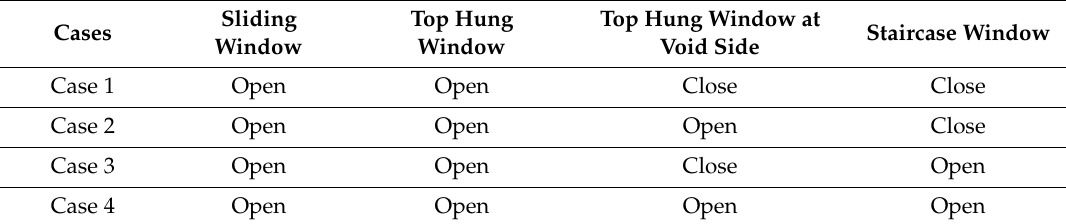
Table 4. Network simulation analysis cases for natural ventilation